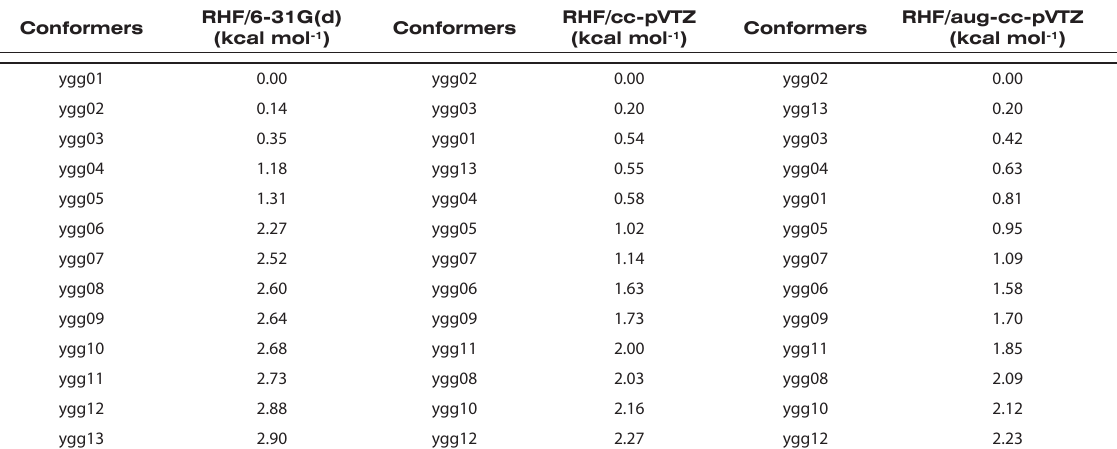
Table 2. Relative energies for the most stable conformers of the YGG tripeptide evaluated with various basis sets (structures are labeled according to Fig. 2). The relative energies were given in kilocalories per mole.